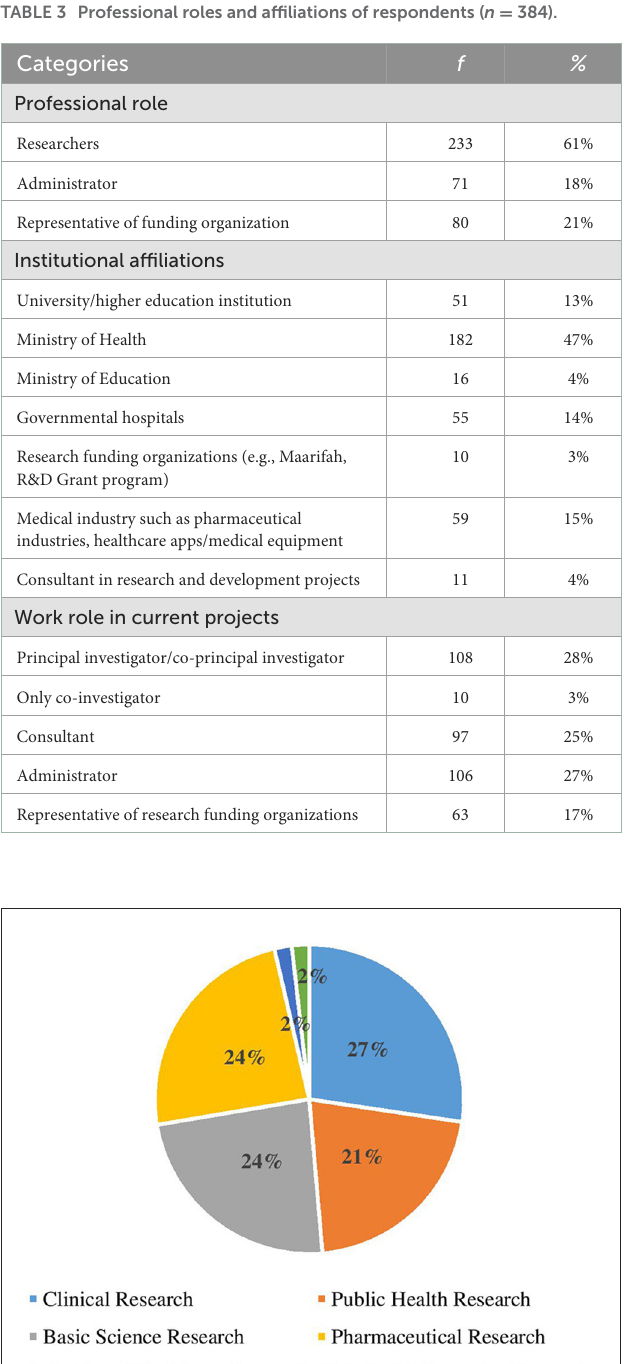
TABLE 3 Professional roles and affiliations of respondents ( n = 384).